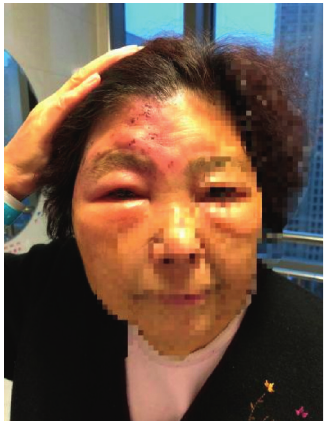
Figure 2: State of the right upper eyelid five days after intravenous administration of vitamin C.